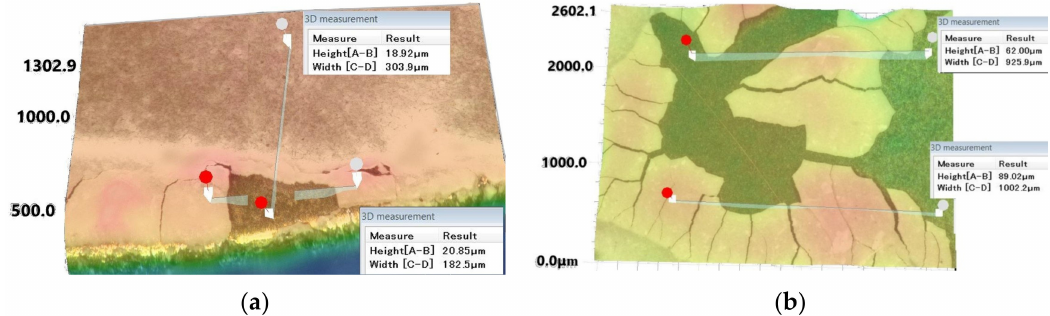
Figure 6. Deposition thickness measurement by stereo imaging on ( a ) 400 ◦ C heat-treated CP-Ti and ( b ) 600 ◦ C heat-treated CP-Ti after immersion with UV irradiation.